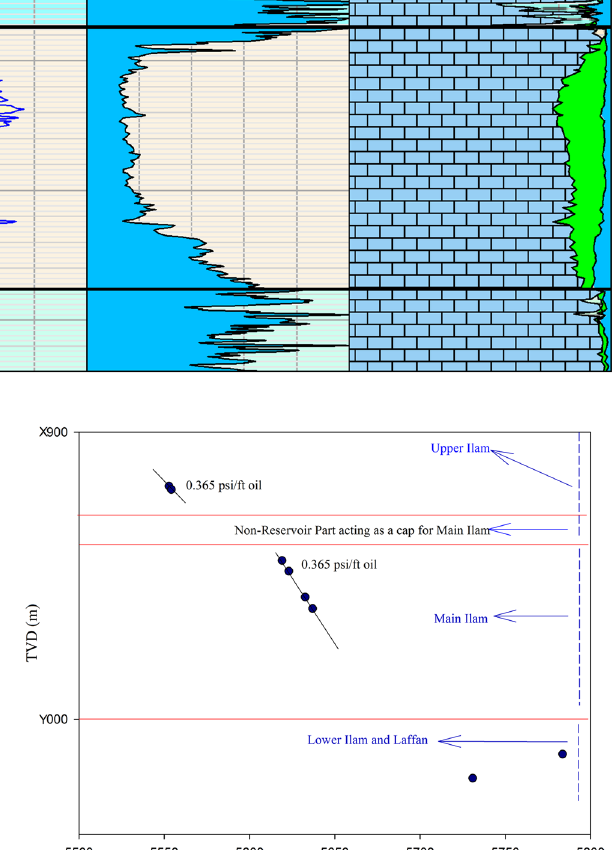
Fig. 3 Typical Ilam Forma- tion in the region under study based on petrophysical logs (Well A-X1). The basal part of the Upper Ilam is the top seal, and the Lower Ilam part acts as the base seal for the Main Ilam Formation